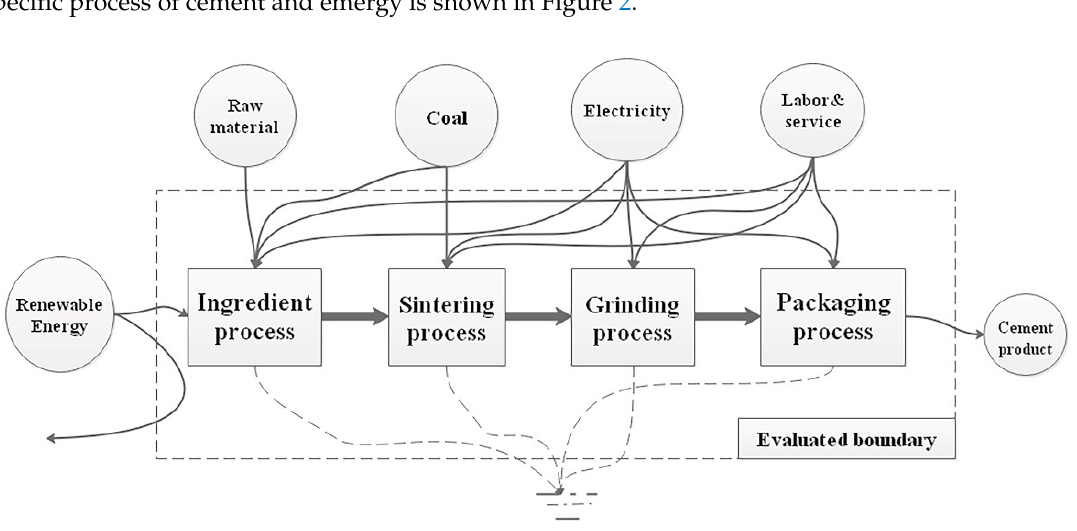
Figure 2. Cement product emergy diagram.